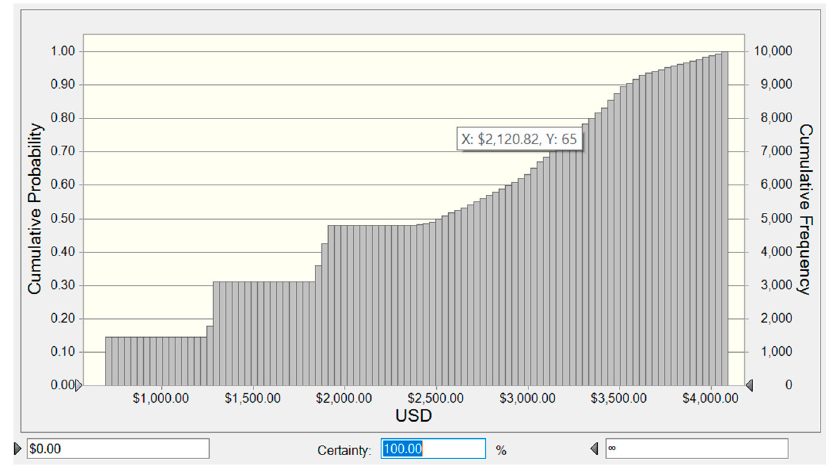
Figure 4. Stochastic results of net present value (NPV) in the NO region.